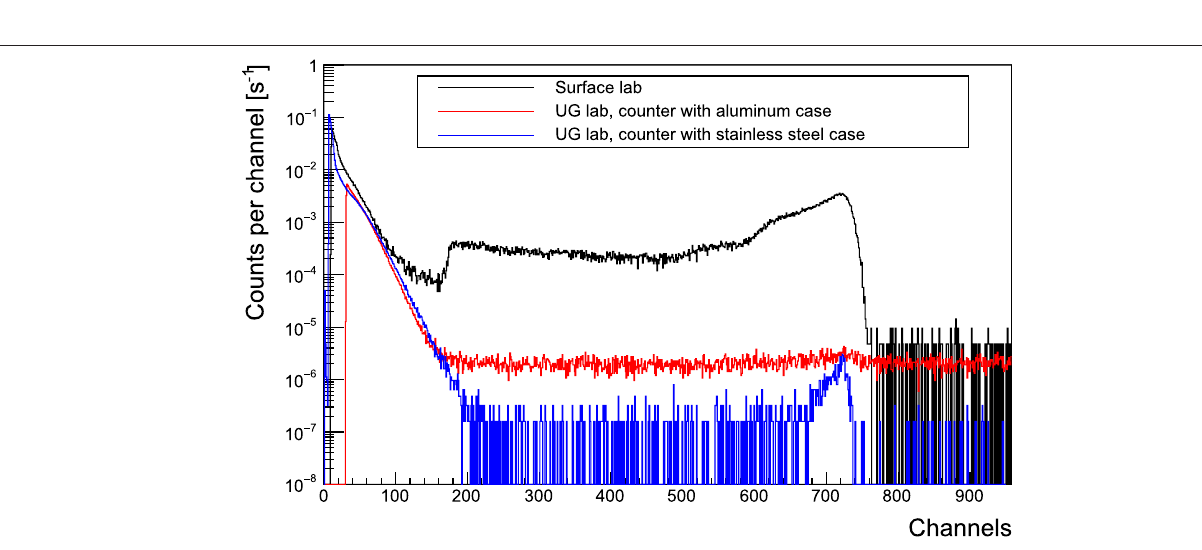
Frontiers in Astronomy and Space Sciences |